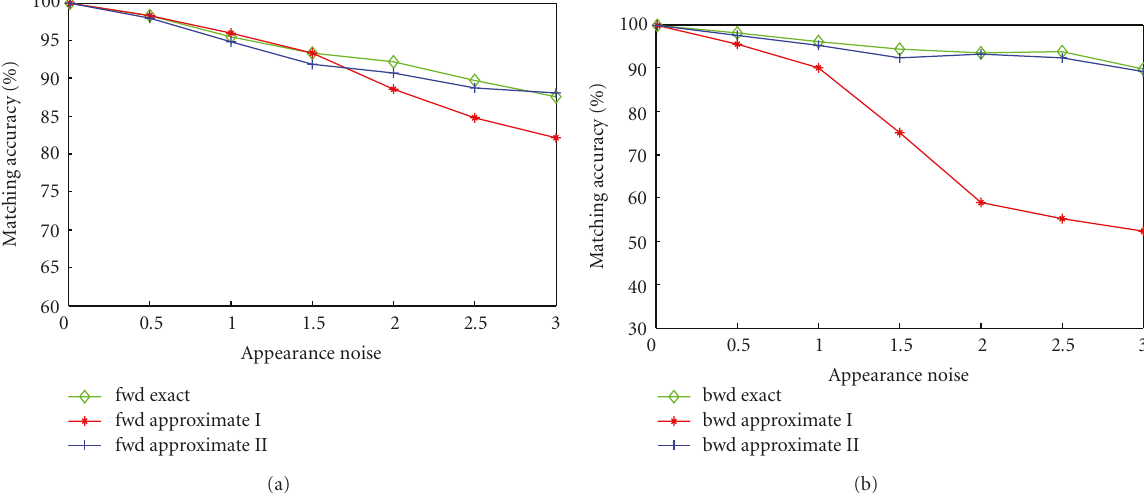
Figure 9: Mean accuracy under di ff erent appearance noise level. X -axis corresponds to the variance of appearance observations. (a) Forward inference. (b) Backward inference.